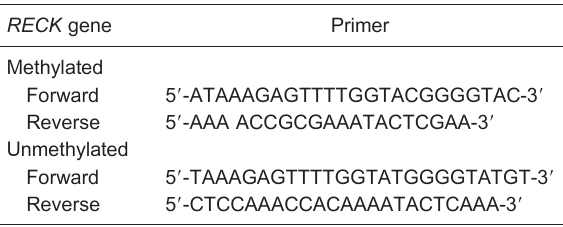
Table 1. RECK primer sequences for methylation-specific PCR.